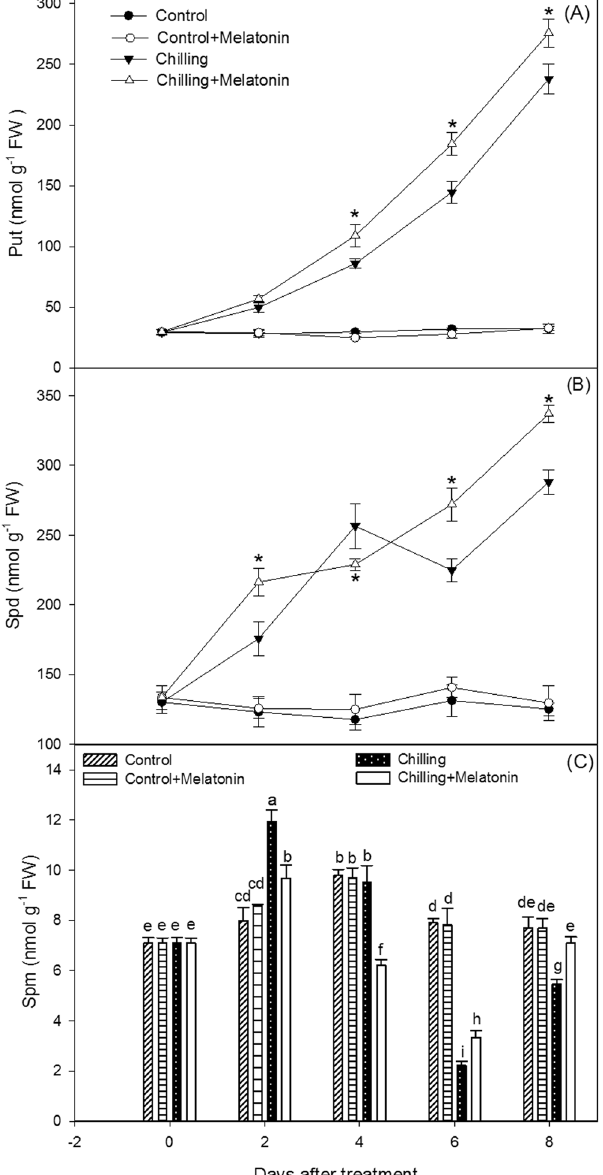
Figure 3. Effects of exogenous melatonin on polyamine contents under chilling stress. ( A ) Putrescine (Put), ( B ) spermidine (Spd), ( C ) spermine (Spm). Control, treating at 28/18 °C; Control + Melatonin, pre-treating with 200 μ M melatonin and treating at 28/18 °C; Chilling, treating at 15/8 °C; Chilling + Melatonin, pre-treating with 200 μ M melatonin and treating at 15/8 °C; Date represent means ± SD of third replicate samples, * Significant difference between different treatments at P < 0.05 based on Duncan’s multiple range